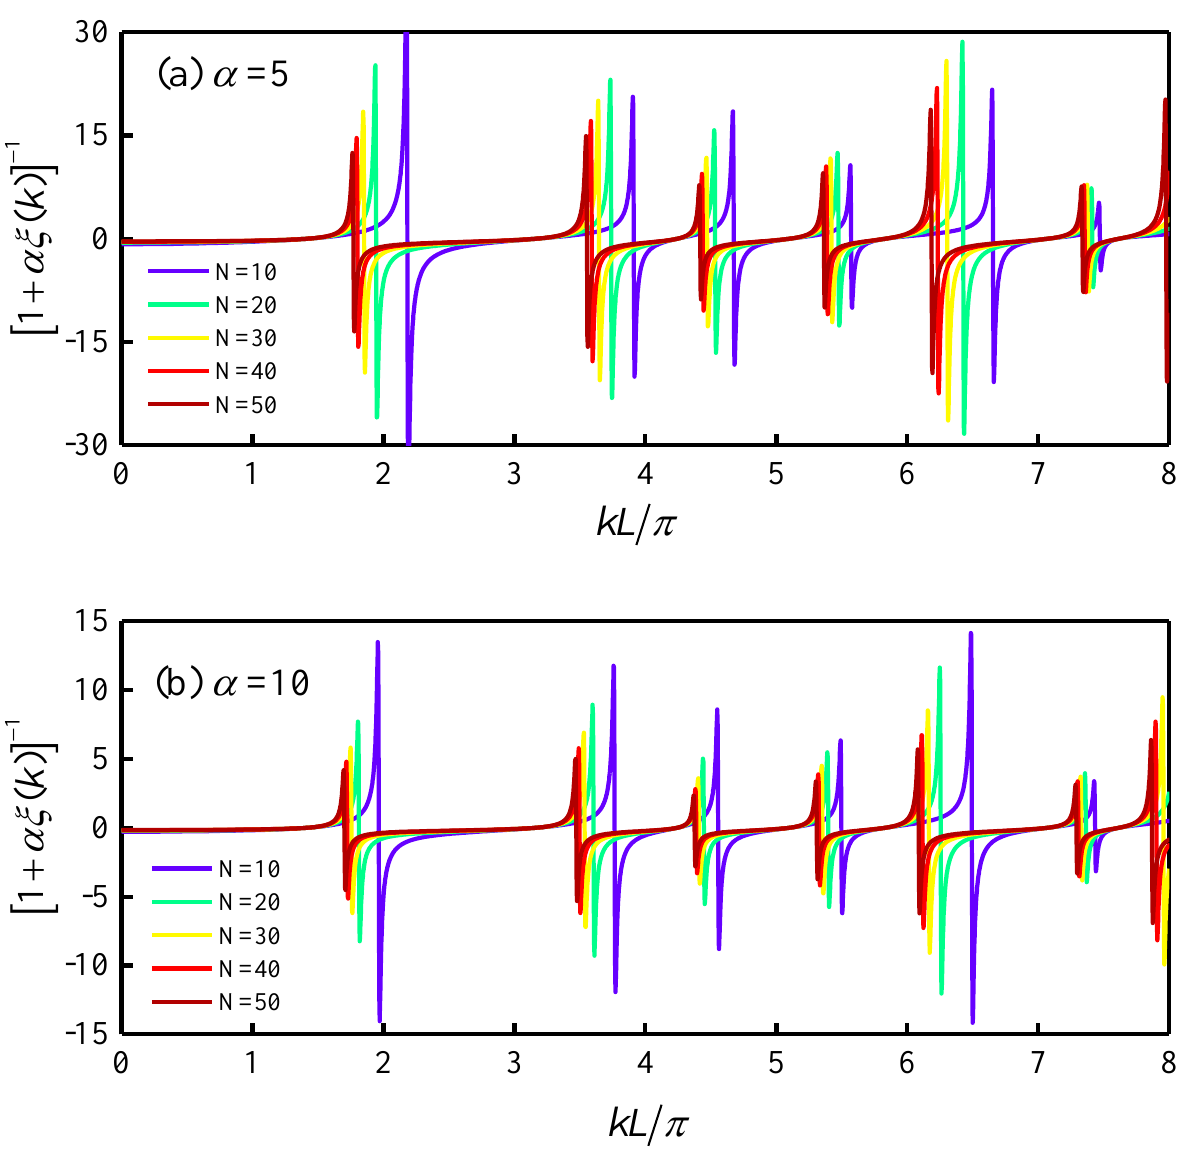
1 1 ( ) k    as a function of k for different N increasing from 10